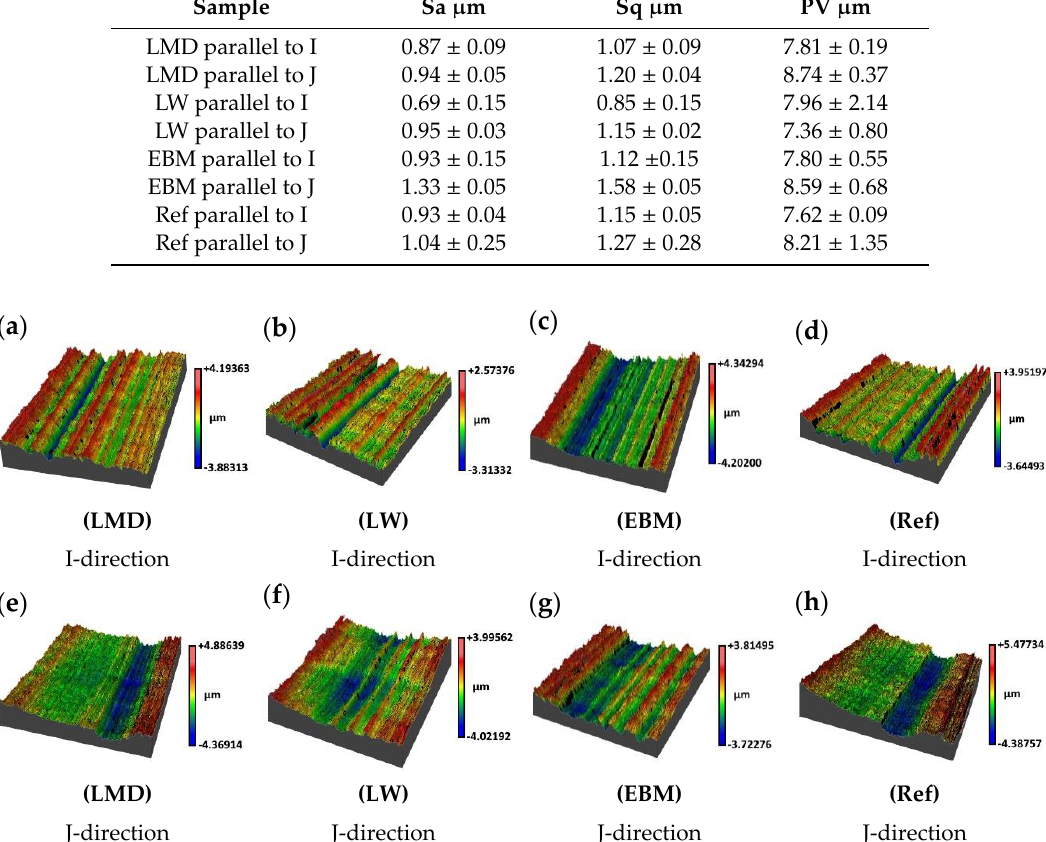
Figure 13. White light interferometry profile projections of analyzed 1 × 1 mm squares. One projection of each sample was selected amongst three measured and are referred to as ( a – h ). The feed direction is along the grooves, so from the bottom to the top of paper.